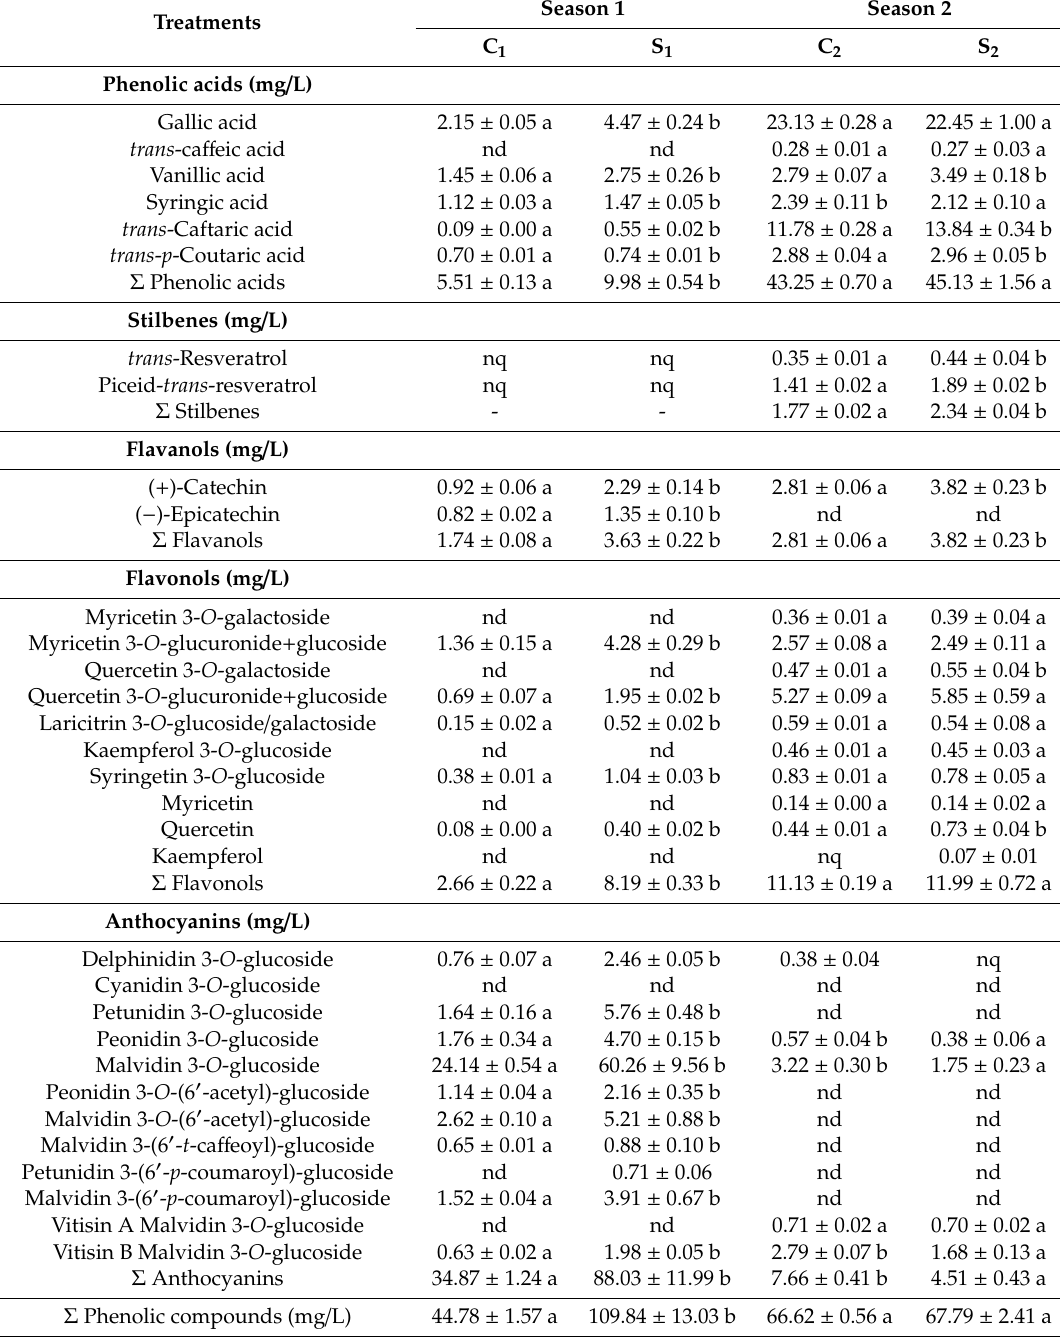
Table 2. Phenolic compounds determined in Bobal